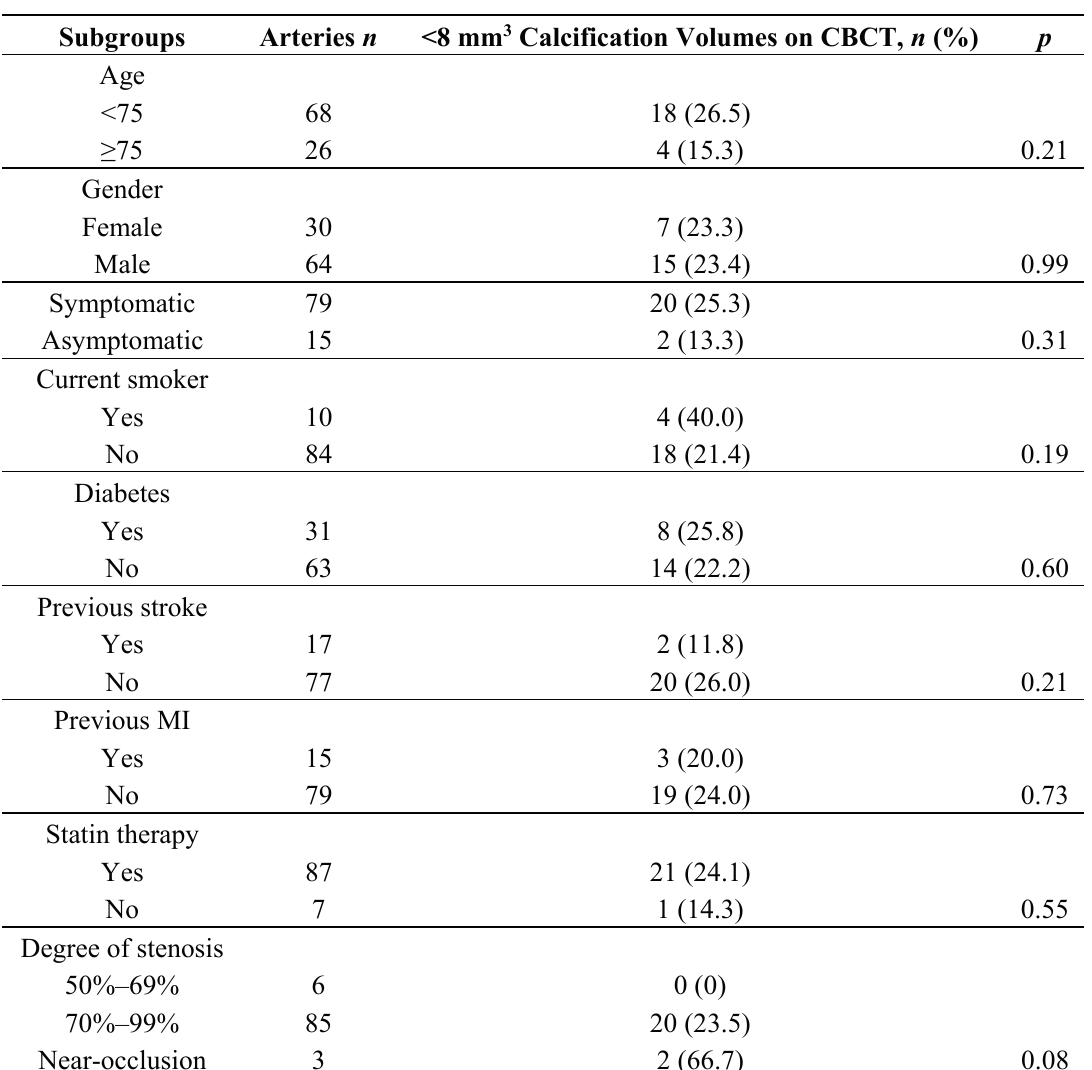
Table 2. Subgroup analyses.